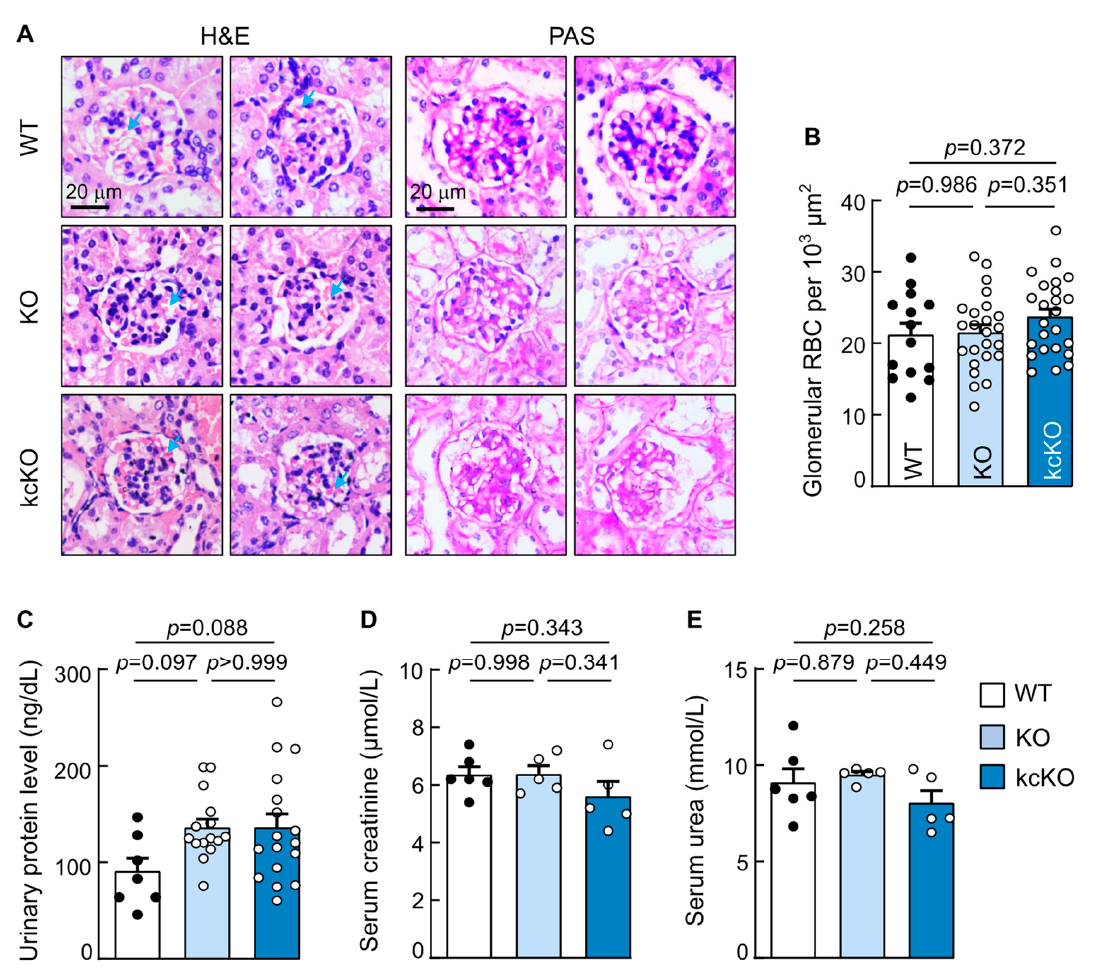
Figure 3. Analysis of renal histology and function in corin kcKO mice. ( A ) Kidney sections from WT, corin KO, and kcKO mice were stained with H&E (two left columns) or PAS (two right columns) and examined under a light microscope. Blue arrows indicate red blood cells (RBCs). Scale bars: 20 µ m. Data are representative of at least three experiments. ( B ) Glomerular RBCs were counted in kidney sections from WT (black dots), corin KO, and kcKO (white dots) mice. n = 14–24 per group. ( C – E ) Levels of urinary proteins ( C ) and serum creatinine ( D ) and urea ( E ) in WT (black dots), corin KO, and kcKO (white dots) mice were measured by a Bradford assay ( C ) or an auto-